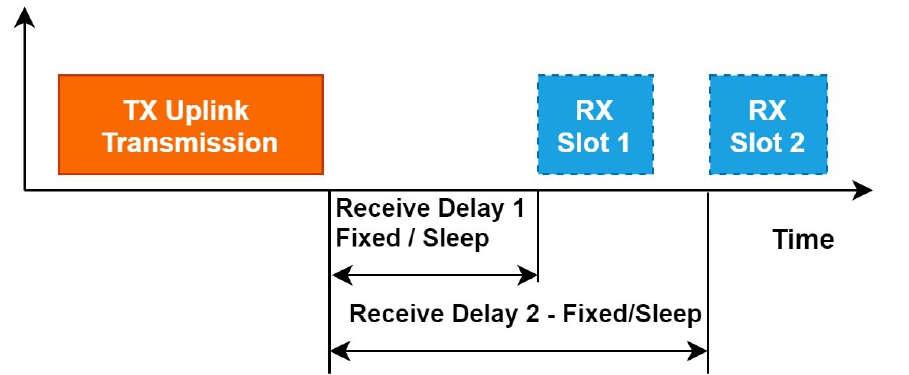
Figure 3. Class A